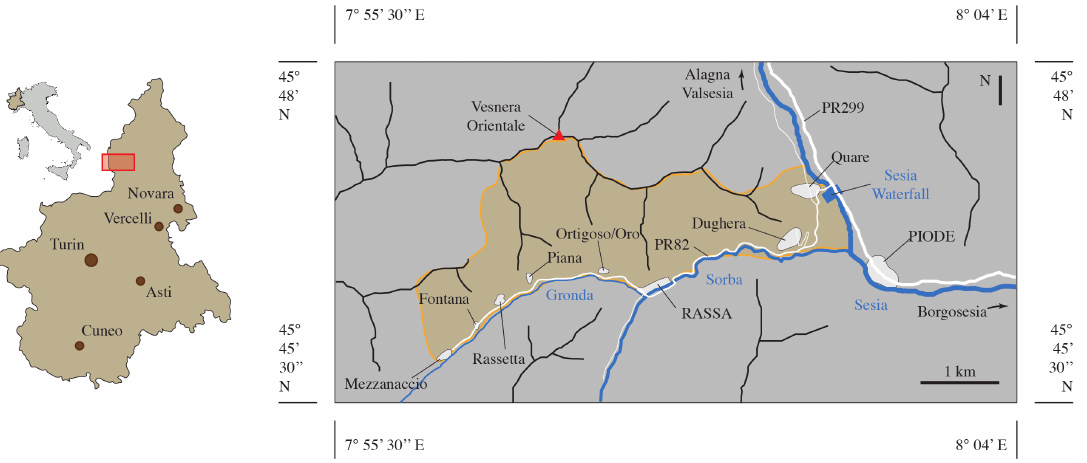
Figure 1. Geographical framework of the study area ( left ) and focus on the investigated area, highlighted with a light yellow shape ( right